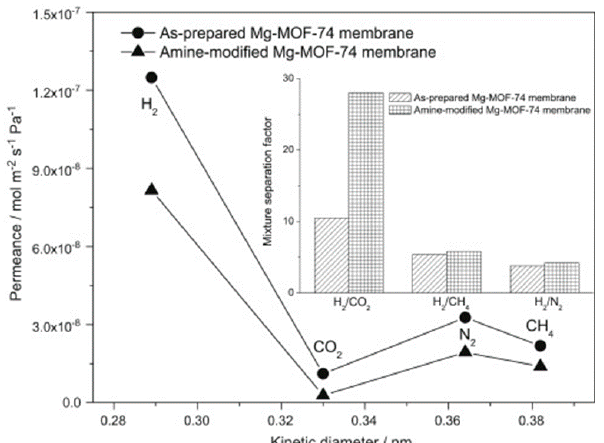
Figure 34. Single gas permeances on the as-prepared and amine-modified Mg-MOF-74 membranes at 25 °C and 1 bar as a function of the kinetic diameter. The inset shows the mixture separation factors for H 2 over other gases from equimolar mixtures (for the temperature dependence of the H 2 /CO 2 mixed gas selectivities) (adapted with permission from ref. [77]).